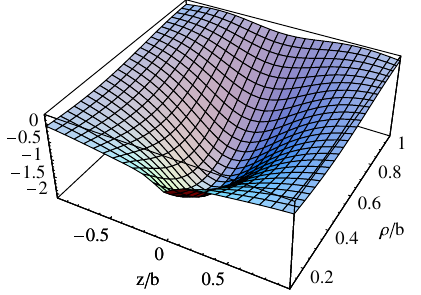
FIG. 7. The transverse force F ρ in units of E 2 0 a 3